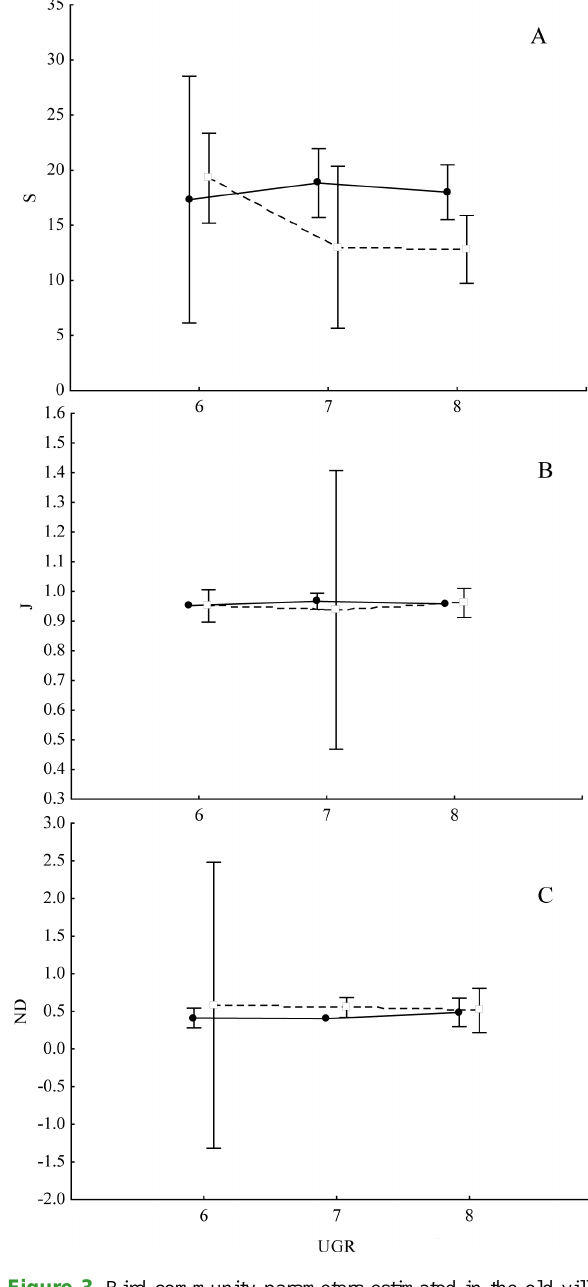
Figure 3. Bird community parameters estimated in the old villas and in the remaining green areas within UGRs 6, 7, and 8. The comparisons were performed by means of generalised linear mod- els with the green area typology and UGR used as categorical pre- dictors. In the plots the marginal means for the interaction e ff ect between the predictors are shown. (A) Species richness ( S ) × UGR = 10 . 286, p = 0 . 006); (B) Evenness ( J ) × UGR (Wald: (Wald: χ 2 (2) = 0 . 523; p = 0 . 769); (C) Dominant species ( Nd ) × UGR (Wald: χ 2 (2) = 0 . 523; p = 0 . 770). Black circles = old villas; Empty squares χ 2 (2) = remaining green areas.